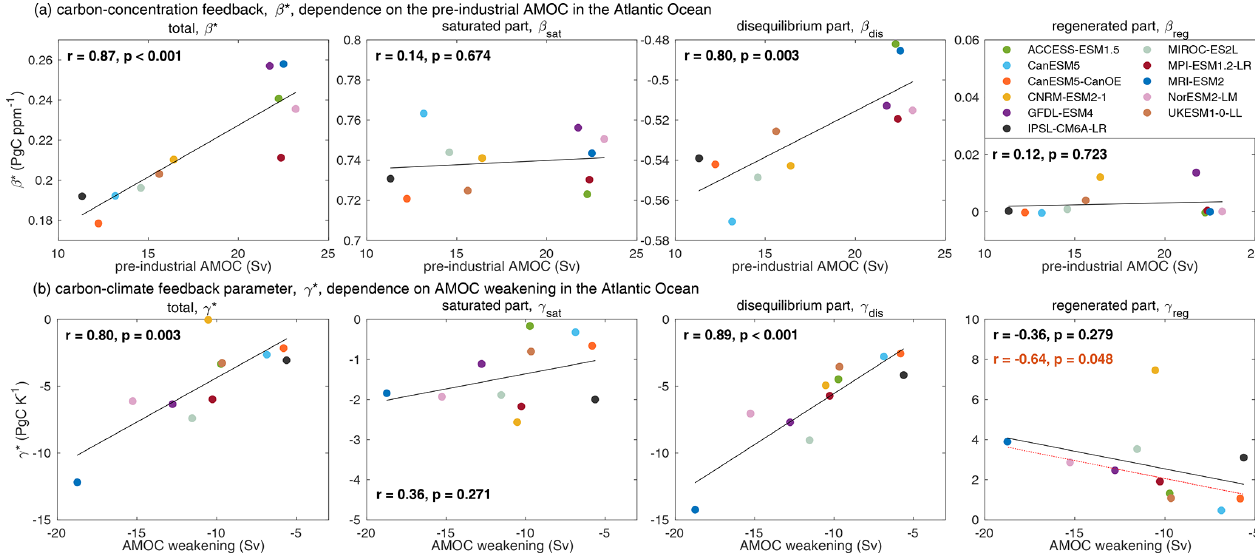
Figure 10. (a) Dependence of the carbon–concentration feedback parameter based on carbon storage, β ∗ (PgCppm − 1 ), on the pre-industrial strength of the Atlantic Meridional Overturning Circulation (AMOC; Sv), in the Atlantic Ocean, and (b) dependence of the carbon–climate feedback parameter based on carbon storage, γ ∗ (PgCK − 1 ), on the AMOC weakening with climate change in the Atlantic Ocean, in 11 CMIP6 models (Table 1), along with the contribution from the saturated, disequilibrium and regenerated carbon pools. The black lines correspond to the regression line based on an ordinary least-squares regression, with the corresponding correlation coefficient, r , and p value shown in each panel. The dashed red line and r and p value in red for γ reg correspond to the regression line and the correlation coefficient estimated by excluding CNRM-ESM2-1, the model with the largest deviation from the rest of the Earth system models in terms of the regenerated carbon pool. The strength and weakening of the AMOC are estimated as the maximum pre-industrial AMOC and maximum AMOC change between 30 and 50 ◦ N, respectively (Table 3). Diagnostics are from years 121 to 140 (the 20 years up to quadrupling of atmospheric CO 2